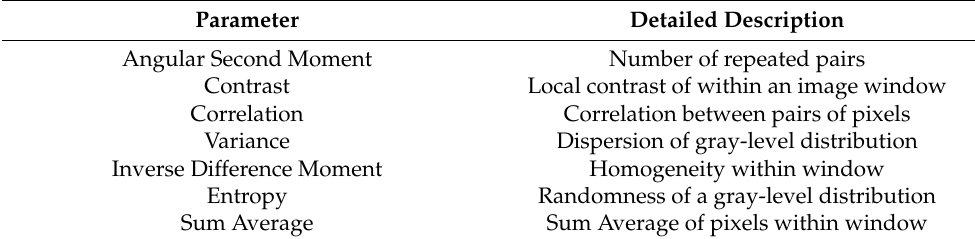
Table 1. Textural measures based on GLCM method in this study.